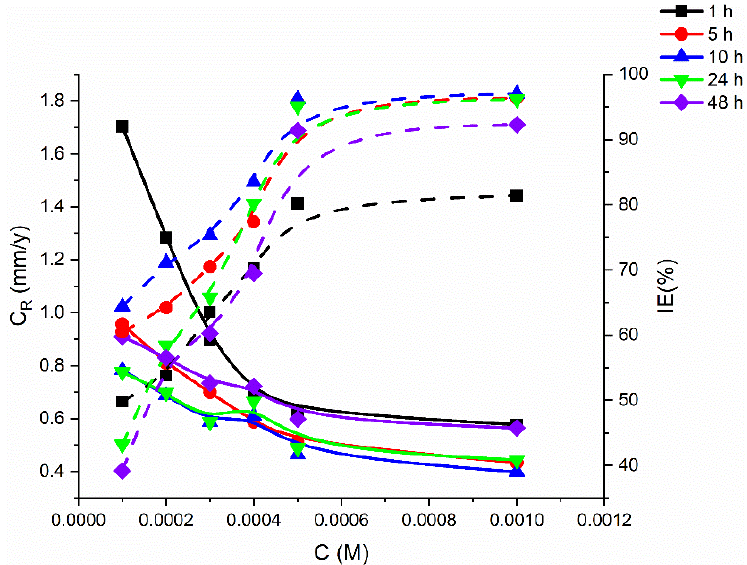
Figure 2. Gravimetric-curve relationship of metal coupons in 1 M HCl between corrosion rate and inhibition efficiency: different exposure periods at 303 K.